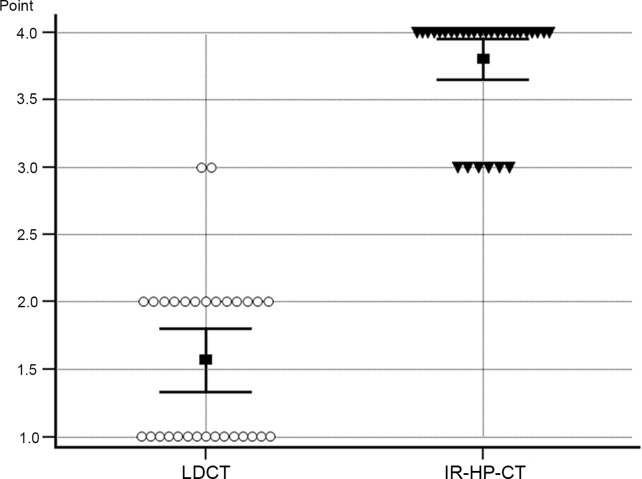
Cardiac pulsation artifacts evident on LDCT and IR-HP-CT scans.IR-HP-CT was associated with a significant reduction in cardiac pulsation (P < 0.0001). The black squares are the means and the horizontal bars the 95% confidence intervals.